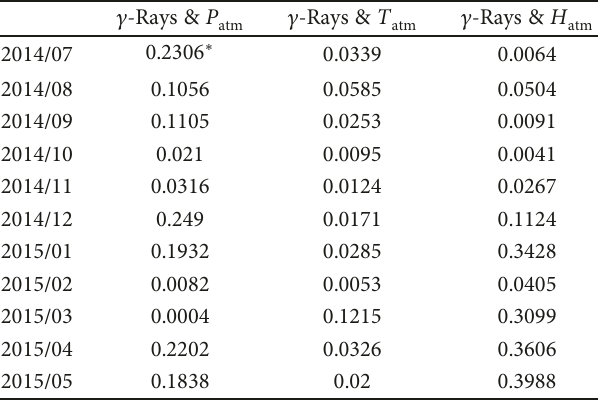
) during di ff erent time atm